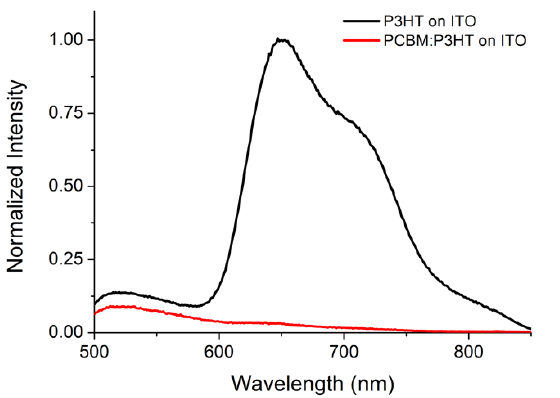
Figure 4. Fluorescence spectra of the P3HT printed film (black line) and of the P3HT:PCBM film (red line), showing the almost complete fluorescence quenching.